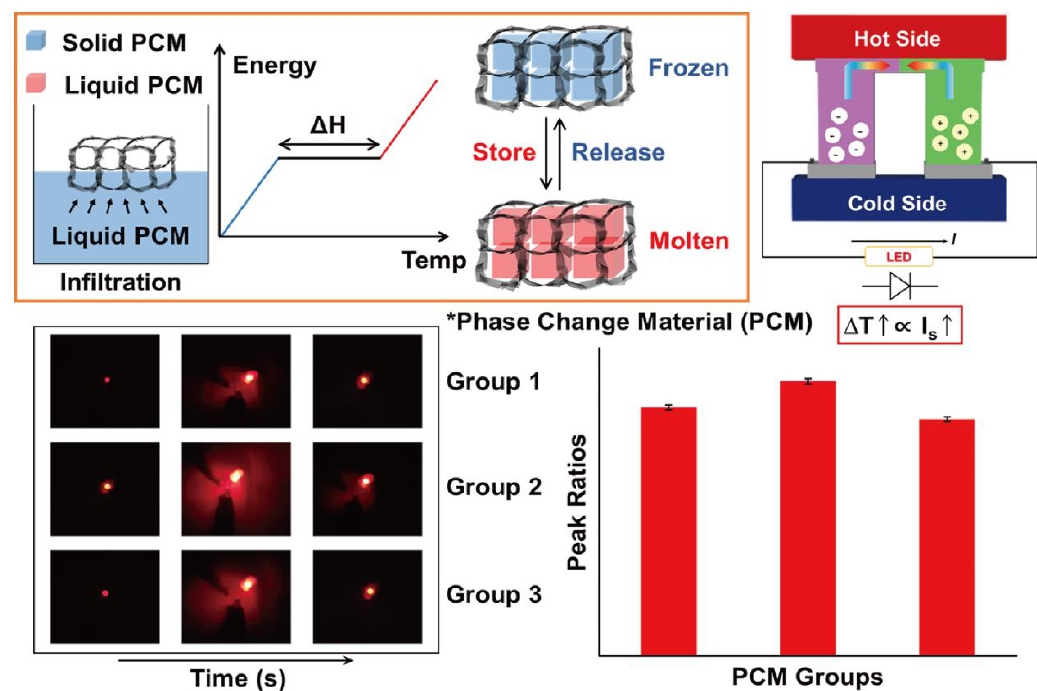
Table 1. BET results of rGO/GNP aerogels with different ratios.